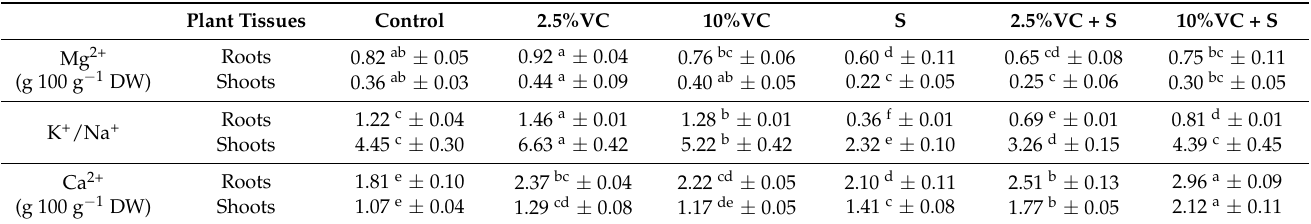
Table 3. Effect of 0, 2.5 and 10% vermicompost, 200 mM NaCl (S) and their interactions on the contents of calcium (Ca 2+ ), magnesium (Mg 2+ ), and potassium/sodium ratio (K + /Na + ) in the roots and shoots of Vicia faba plant after 30 days of cultivation. Values are means ± SD based on triplicate independent determinations, and different letters means significant difference as evaluated by Duncan’s multiple comparison test ( p <